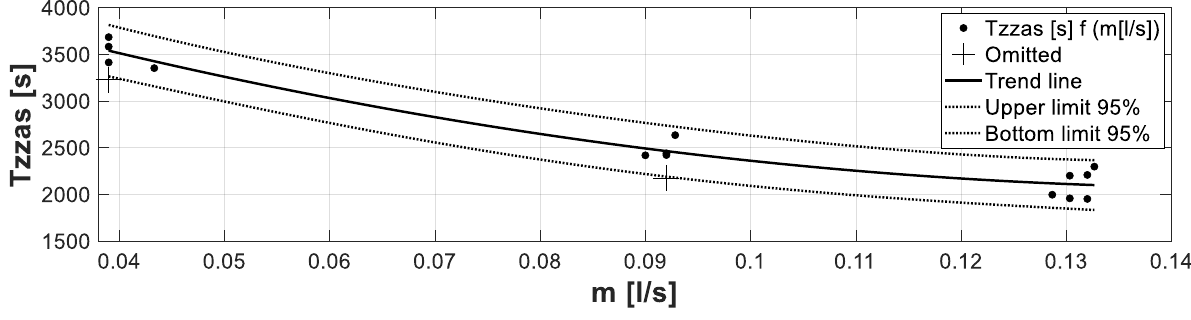
Figure 13. Impact of the circulator pump output on the value of the time constant of the heat exchanger.